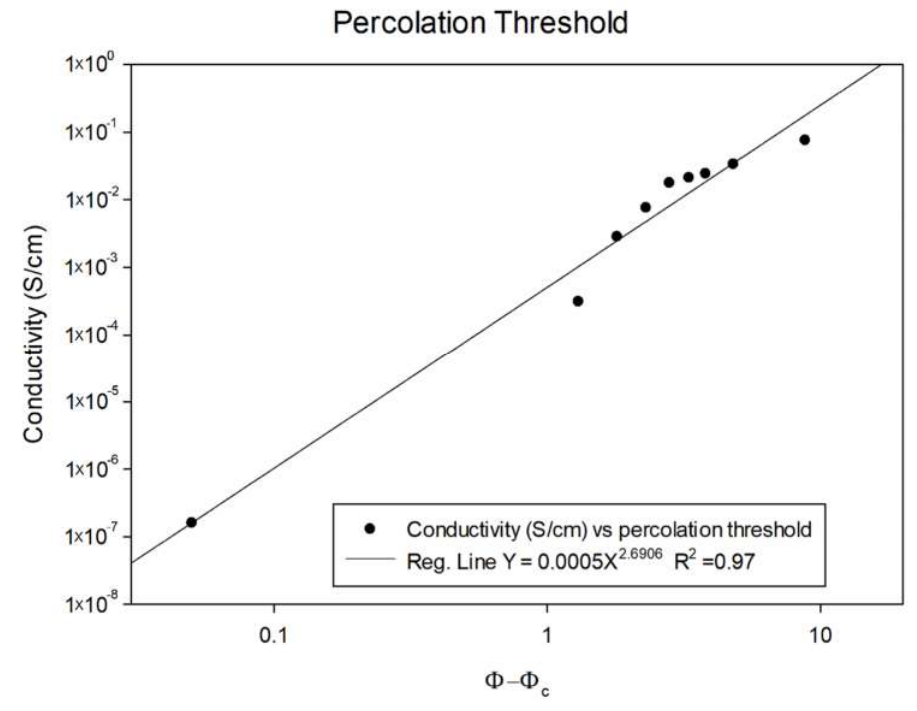
Figure 4. Calculating percolation threshold based on a best linear fit to experimental data.